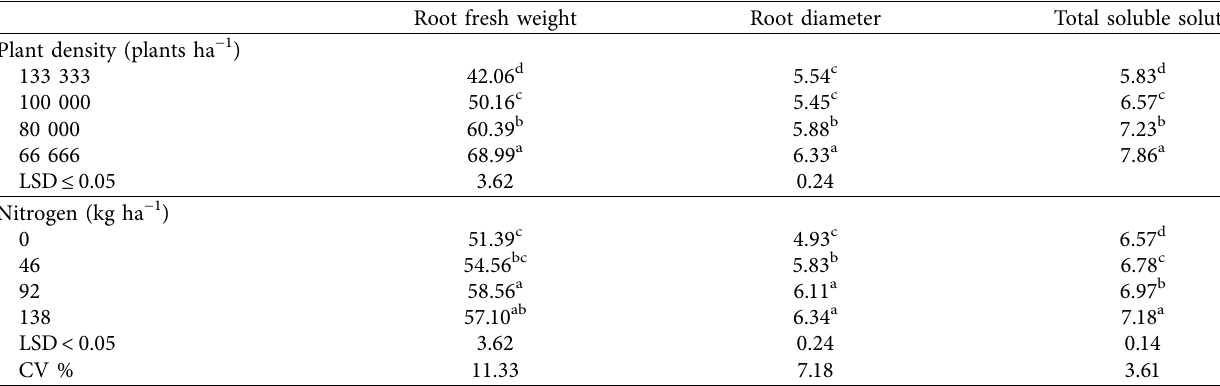
Table 2: Mean root fresh weight, root diameter, and total soluble solute of beetroot influenced by plant density and N fertilizer rates. Root fresh weight